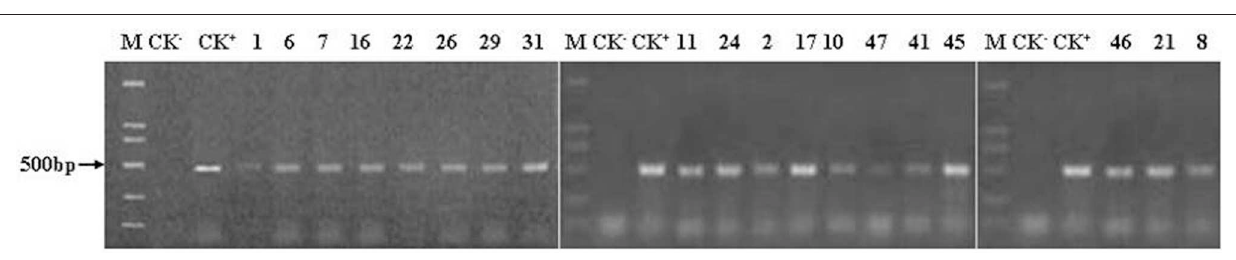
differed between lines of different ages: 10 lines (52.6%) of the 1-year-old transgenic plants and 8 lines (42.1%) of the 2- year-old transgenic plants had C. anachoreta larval mortality rates exceeding 80%, whereas only five lines (26.3%) of